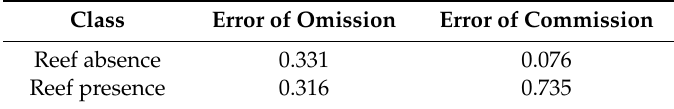
Table 6. Class-specific errors of omission and commission for the OBIA